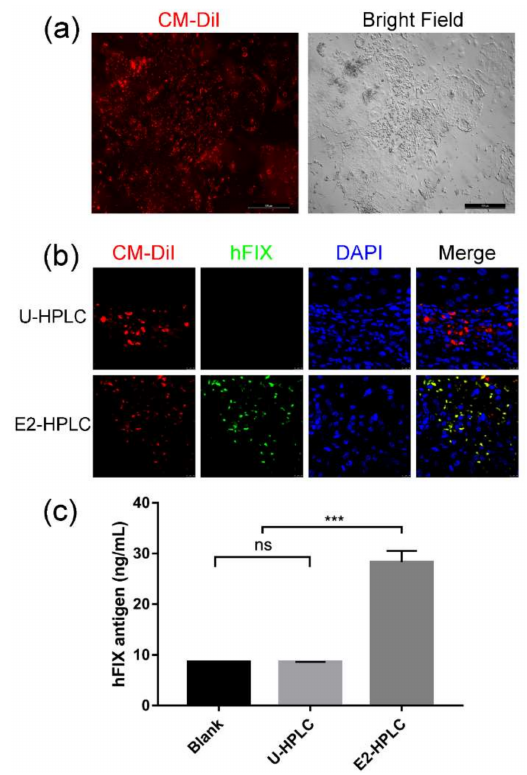
Figure 5. Transplanted HPLCs survived in the liver and produced human Factor IX. ( a ) HPLCs on Day 13 were labeled with CM-DiI. The red fluorescence showed the CM-DiI labeled cells. Scale bar: 500 µ m. ( b ) Four weeks after intrasplenic transplantation of HPLCs (Red) into SCID mouse with carbon tetrachloride-induced liver damage. Immunofluorescence staining on liver sections was performed to detect human Factor IX (Green). Scale bar: 10 µ m. ( c ) Four weeks after transplantation, the plasma of mice was collected and human Factor IX antigen was detected by ELISA. Blank, mice injected with PBS; U-HPLC, HPLCs differentiated from un-targeted mESCs; E2-HPLC, HPLCs differentiated from Neo cassette excised clone E2. ns, not significant; ***, p <